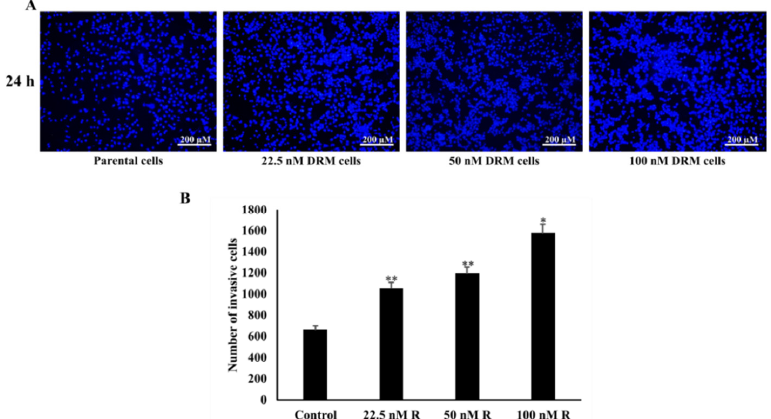
Figure 3. Cell proliferation ability. DRM cells showed high proliferation rates compared to parental cells. Parental MDA-MB-231 and DRM cells were seeded, and media was changed every 3 days. After 10 days, cells were stained with Giemsa stain and photographed. Results were confirmed by three independent experiments. DRM: Doxorubicin-resistant MDA-MB-231. (* p < 0.05 vs. control; ** p < 0.001 vs. control). DRM: Doxorubicin-resistant MDA-MB-231. Resistance to chemotherapy as a result of continuous exposure to the chemotherapeutic drug is usually accompanied by the enhanced migration and metastasis of tumor cells [28]. Therefore, we checked whether DRM cells increased the ability of invasion, migration, and adhesion. The transwell invasion assay showed a significant increase in an invasion of DRM cells with the advancement of resistance to higher concentrations of doxorubicin. The relative invasion ability of the 22.5 nM, 50 nM, 100 nM DRM cells, and the parental cells as control were 151%, 181%, 238%, and 100% at 24 h, respectively (Figure 4A). With regard to the cell migration, the wound healing assay indicated the area of wound closure in 22.5 nM, 50 nM,